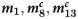
Fits from the best models in each family (m1,m8c,m13c).Model fits and RT histograms for each condition collapsed across subjects. For more details see Figs 6 and 8.